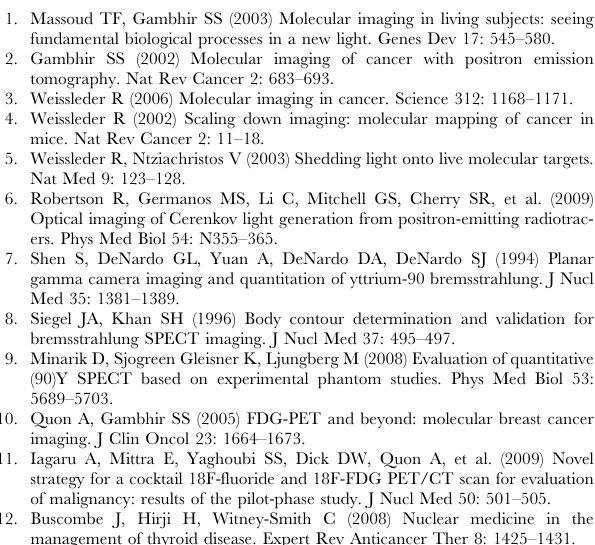
Figure S2 Radioactive OI spectra of 90 Y, 18 F and 131 I by Fluoro Max-3. The spectra are consistent with those obtained by